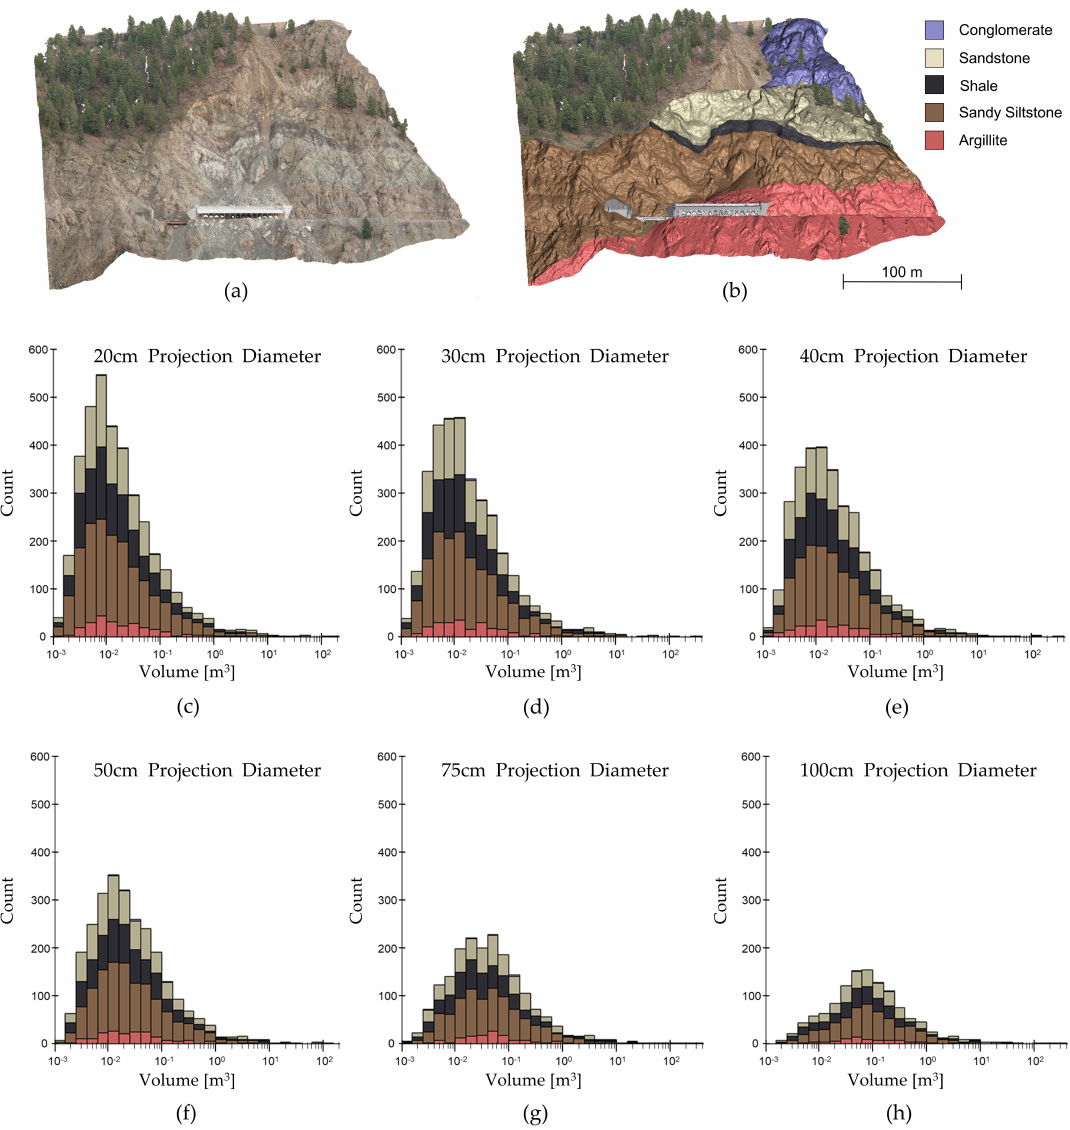
Figure 11. Visual representation of the distribution of rockfall events with respect to their volume and lithology, for each of the six rockfall inventories. ( a ) The oblique helicopter photogrammetry point cloud; ( b ) The photogrammetry point cloud classified by lithology; ( c – h ) Histograms for each of the six rockfall inventories using di ff erent M3C2 projection diameters. Rockfalls are binned according to their volume. The colors in the histograms correspond to the lithologies mapped in ( b ). An increase in the projection diameter significantly reduces the number of lower magnitude − 3 − 1 rockfalls that are extracted, specifically in the range of 10 to 4 × 10 m 3 , shown by the downward shift in the early portion of the cumulative frequency-magnitude relationships in Figure 12. The linear portions of all the cumulative frequency-magnitude relationships are similar for the tested projection diameters. The relative deviations in volume are higher at the magnitudes of 5 to 400 m 3 , causing the cumulative frequency-magnitude curves to diverge. The curves converge again at the largest magnitude event recorded, where there is less relative deviation in